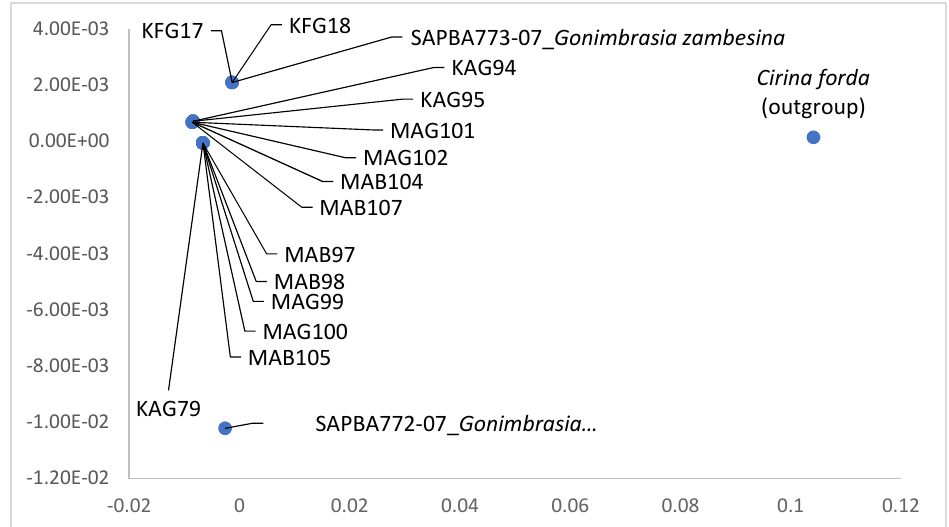
Table 3. Genetic p-distance comparisons for saturniid species.